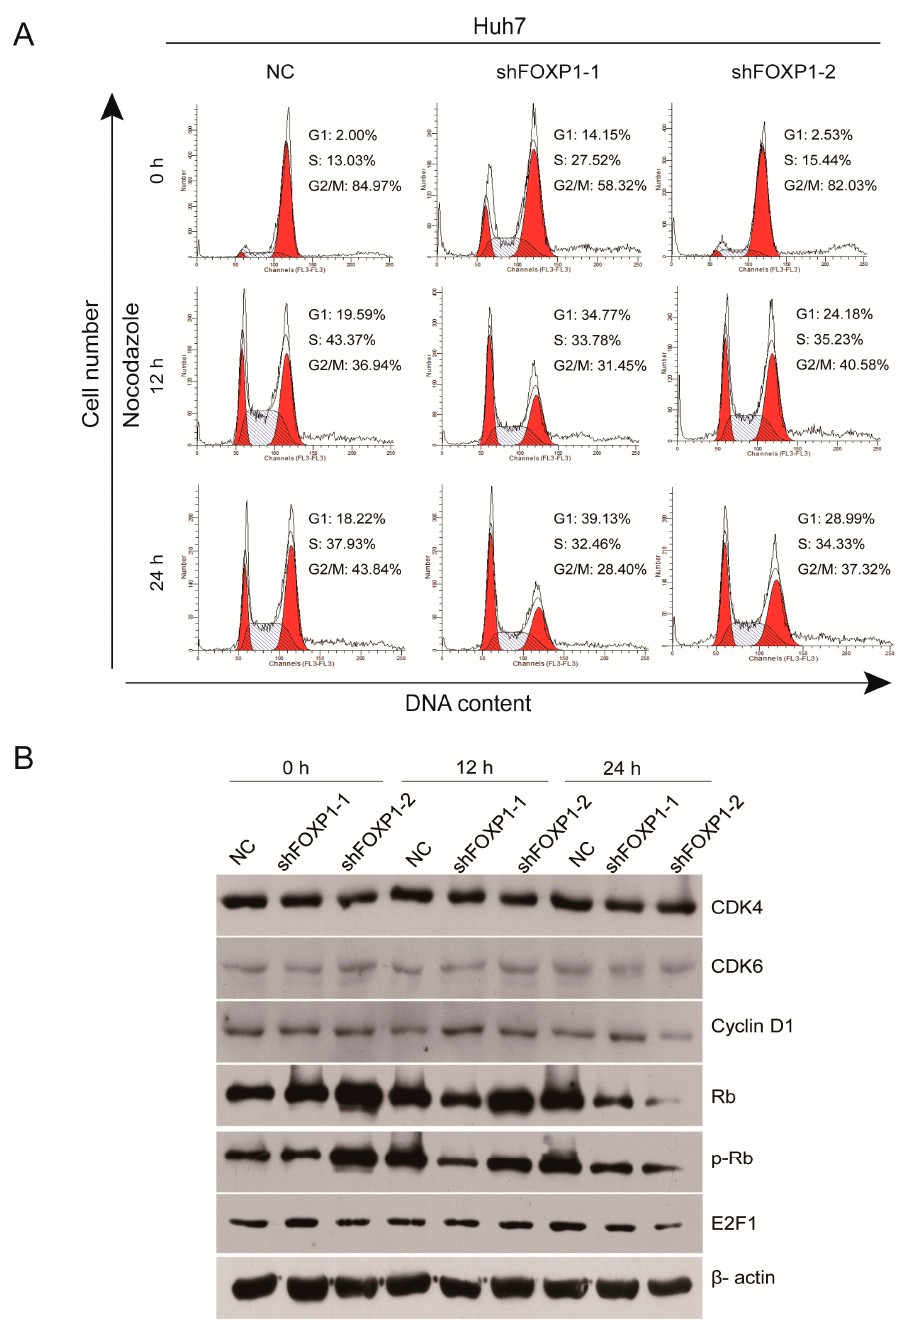
Figure 4. The effect of FOXP1 on G1/S phase transition and cell cycle-related proteins in HCC cells. ( A ) The cell cycle distribution of Huh7 cells that were stably transfected with either shFOXP1 or a scrambled sequence control; ( B ) Western blot analysis of the expression of G1/S phase transition-related proteins (CDK4, CDK6, cyclin D1, p-Rb, Rb, and E2F1) in Huh7 cells. β -actin was used as a loading control.